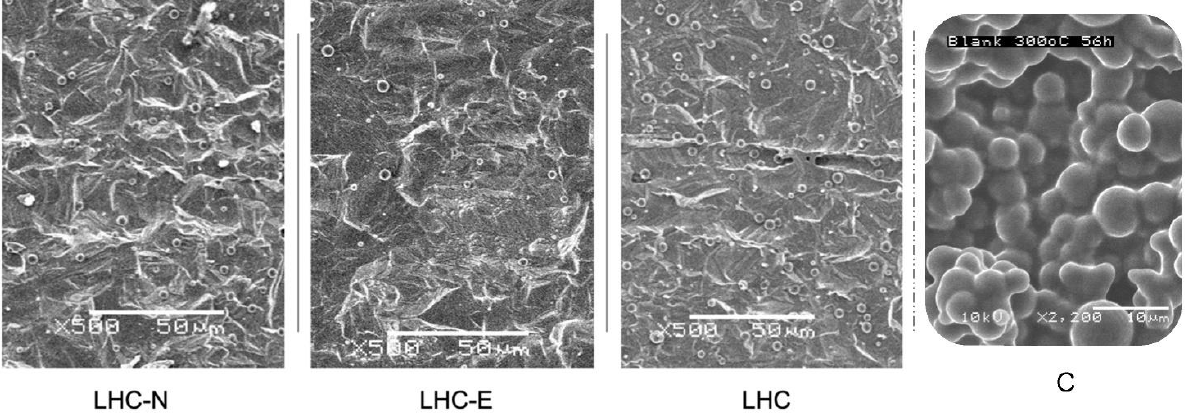
Figure 8. Coking extents inside the three sample tubes vs. the crude tube after a cycle (56 h) of heating sealed lubricant at 300 °C. The scale bars are 50 μ m in the left three images and 10 μ m in C.